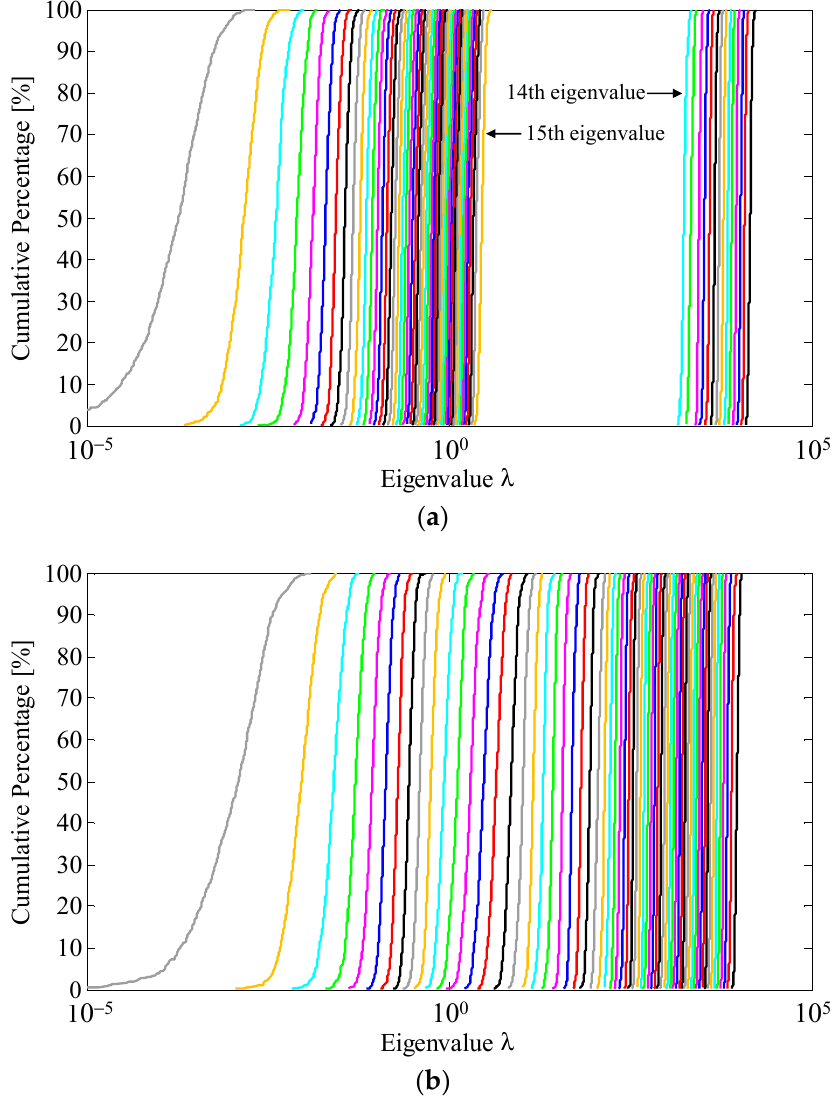
Figure 6. CDF characteristics of the eigenvalues: ( a ) previous method; ( b ) proposed method.